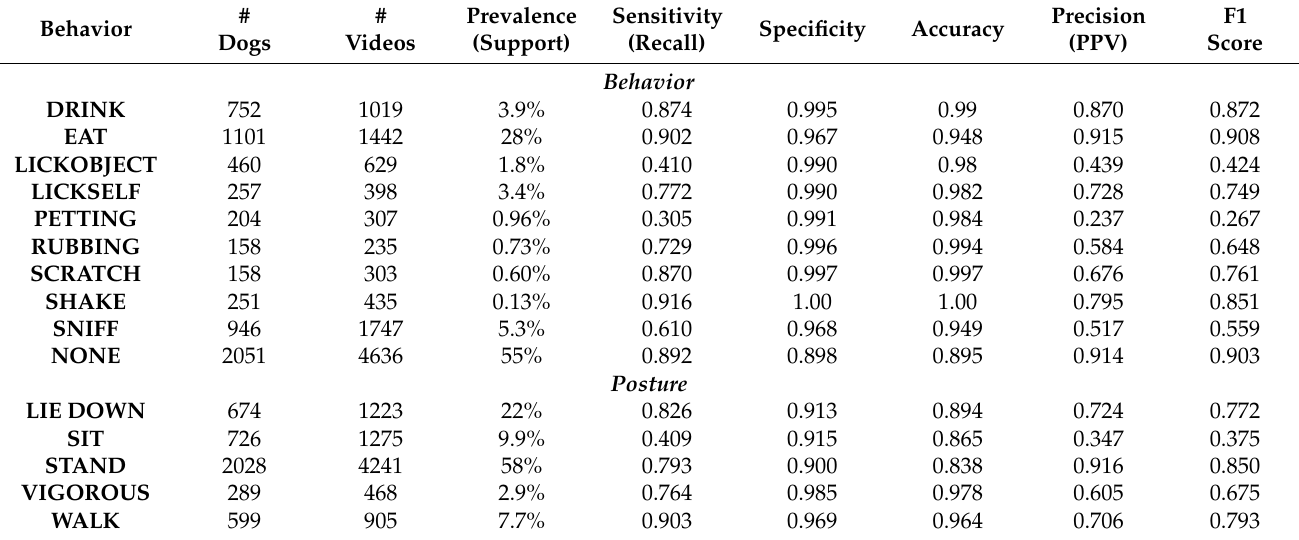
Table 6. Classification metrics for the crowd dataset.